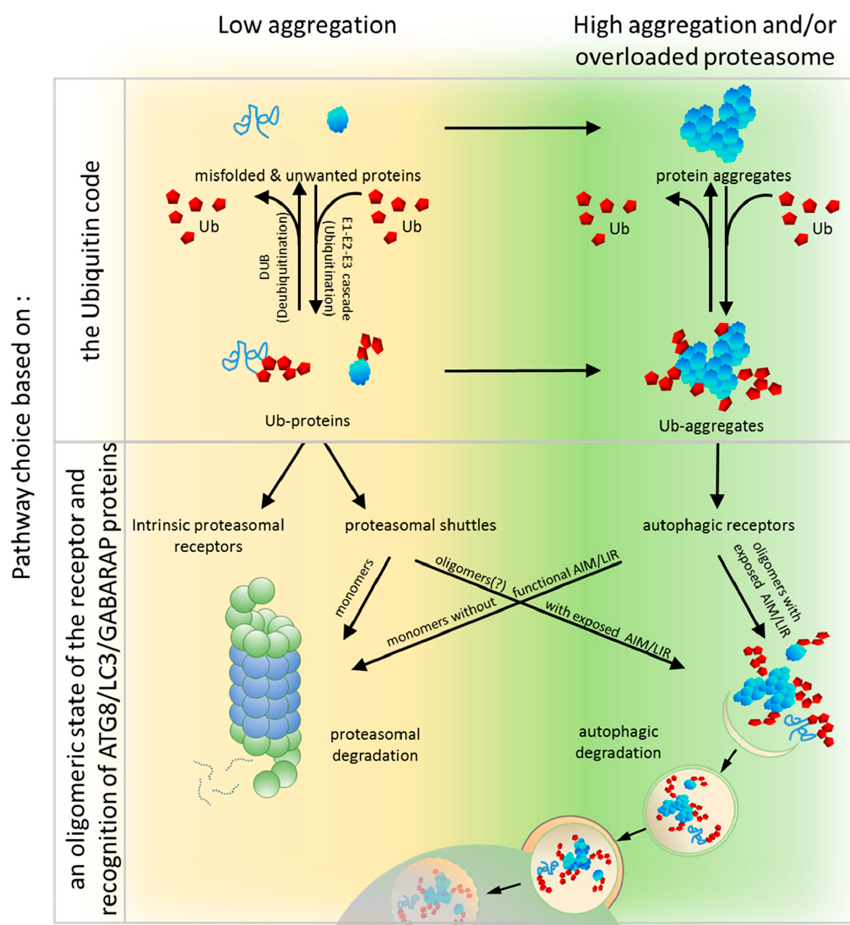
Figure 3. A model for the substrate fate based on the Ub code and an oligomeric state of the receptor and recognition of ATG8/LC3/GABARAP (autophagy-related protein 8/microtubule-associated protein 1A/1B-light chain 3/GABA type A receptor-associated protein) proteins. The PQC network targeting misfolded or unwanted proteins via ubiquitination for degradation is hierarchically organized, but retains flexibility and coordinates the Ub-proteasome system (UPS) and autophagy pathways, according to cellular needs. In the low aggregation (undisturbed) condition, unwanted proteins initially become substrates for the UPS. During ubiquitination, particular Ub labels are attached to the target proteins via the E1–E2–E3 enzyme cascade. This process is reversed by deubiquitinases (DUBs). When the Ub code is written on the substrates, the cargos are then primarily recognized by intrinsic or shuttling proteasomal receptors characterized by higher affinity to Ub in comparison to the affinity of autophagic receptors to Ub. Simultaneous binding of shuttle receptors (probably in monomeric states) to ubiquitinated cargo and proteasomal proteins permit the transfer of the degradation substrates to the proteasome. However, in high aggregation conditions such as when proteasomes are overloaded or when misfolded or redundant proteins accumulate and form aggregates on which Ub is locally concentrated. Such aggregates are mainly recognized by autophagic receptors, which in their oligomeric states have high avidity for Ub and spontaneously coalesce with ubiquitinated proteins into larger clusters that further promote substrate aggregation and delivery to the autophagic machinery. In times of cellular need, shuttling receptors from the proteasomal or autophagic clearance pathways adapt to the alternative, but functional, degradation system to support cellular proteostasis. Proteasomal shuttles with exposed AIM/LIR motif and/or with a